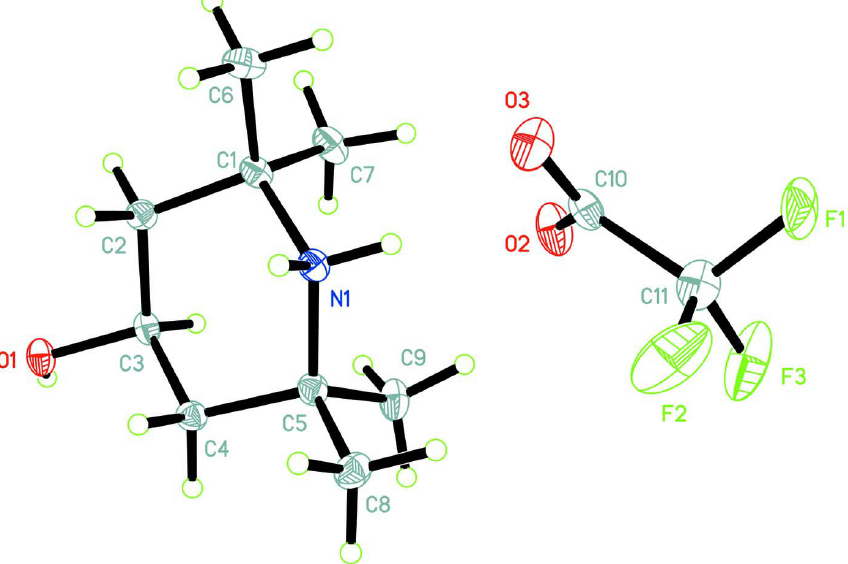
A perspective view of the title compound. Displacement ellipsoids are drawn at the 30% probability level and H atoms are shown as small spheres of arbitrary radii. Only the major occupied site of the disordered CF